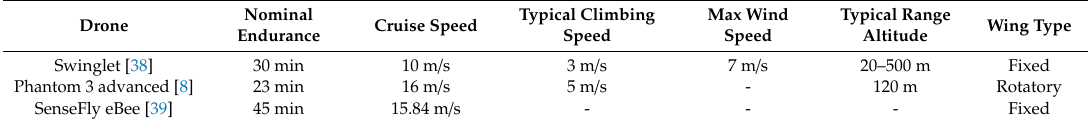
Table 1. Characteristics of commercial drones for PA